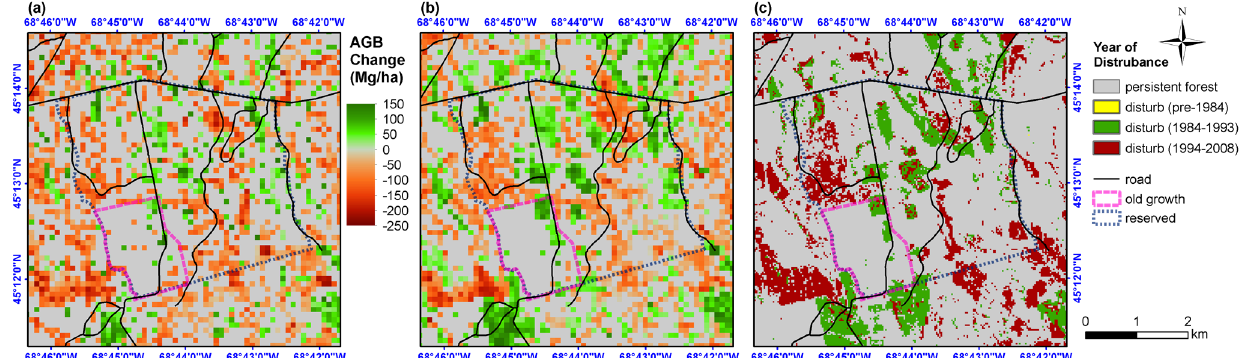
Figure 11. Change in biomass for HF site using cross-image normalized multi-source SAR data. ( a ) 2009PALSAR-1994SIR-C at 100 m spatial resolution, ( b ) 2009UAVSAR-1994AIRSAR at 100 m spatial resolution, and ( c ) reclassified year disturbance derived from LTSS-VCT product at 30 m spatial resolution. Different colors represent reclassified groups: prior to 1984 (yellow), between 1984 and 1993 (green), and between 1994 and 2008 (red),